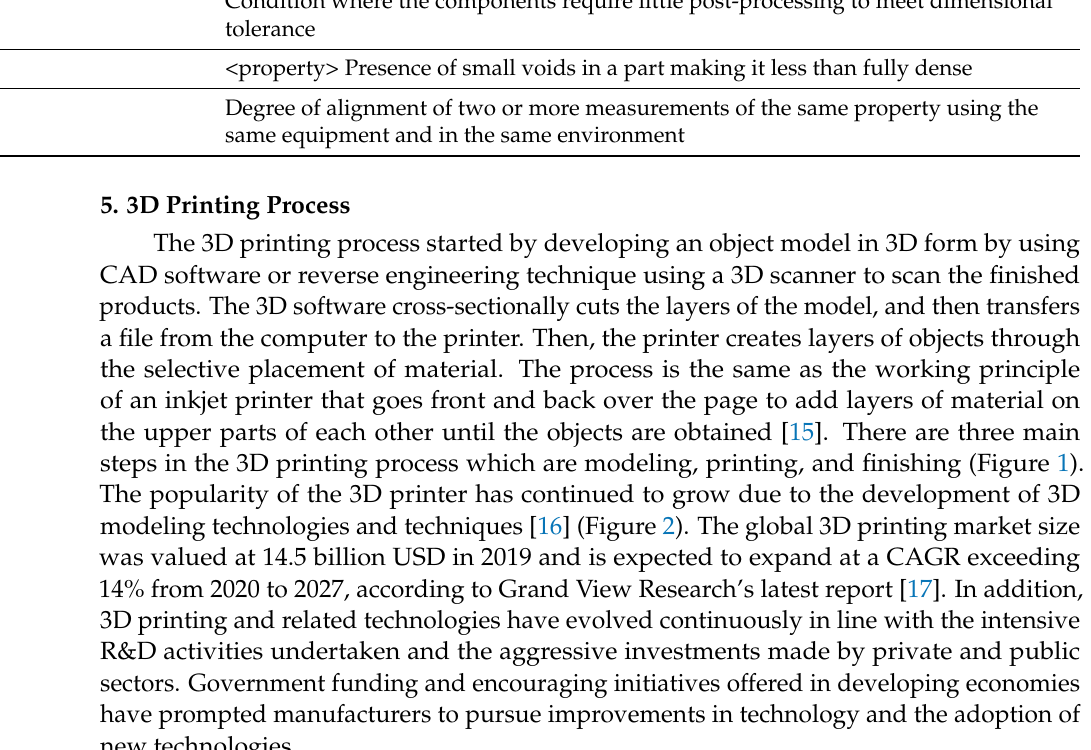
Figure 2. 3D printing market size worldwide, from 2013 to 2021. 6. Types of 3D Printing There are several types of 3D printing machines available that are used in the manufacturing field (Figure 3). All of the machines can be differentiated based on their 4.4